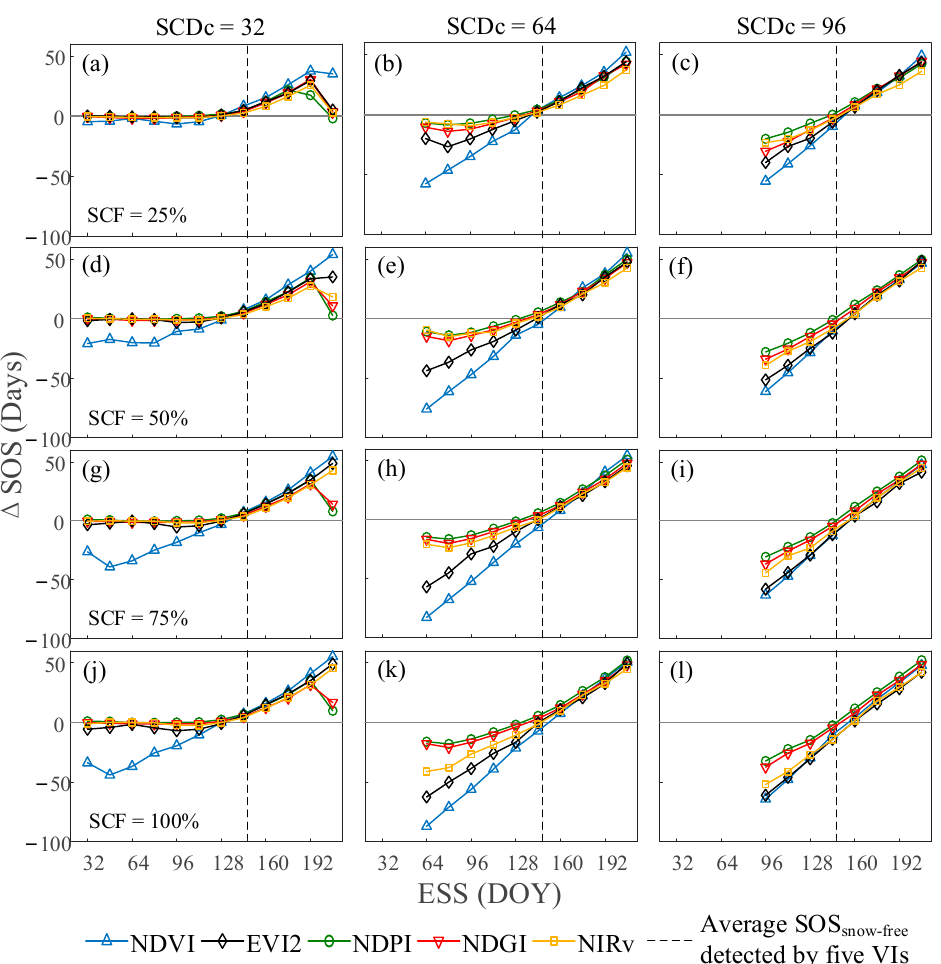
Figure 12. Changes in Δ SOS with increasing ESS under different SCF and SCDc cases derived from simulation experiment III. ( a – c ), ( d – f ), ( g – i ), and ( j – l ) are the changes in the Δ SOS with ESS for four cases of SCF = 25%, 50%, 75%, and 100%, in each group of which three cases of SCDc = 32, 64, and 96 were plotted.